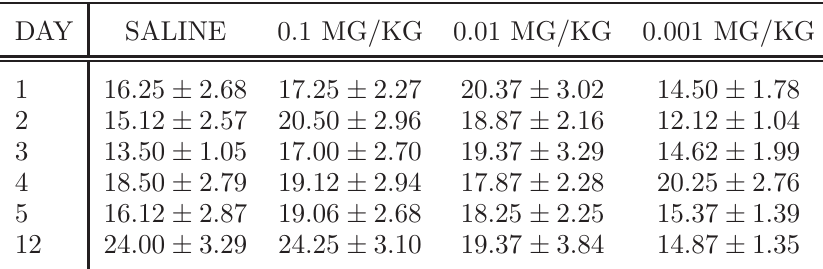
Table 2 Effects of CGP 63360 on active avoidance